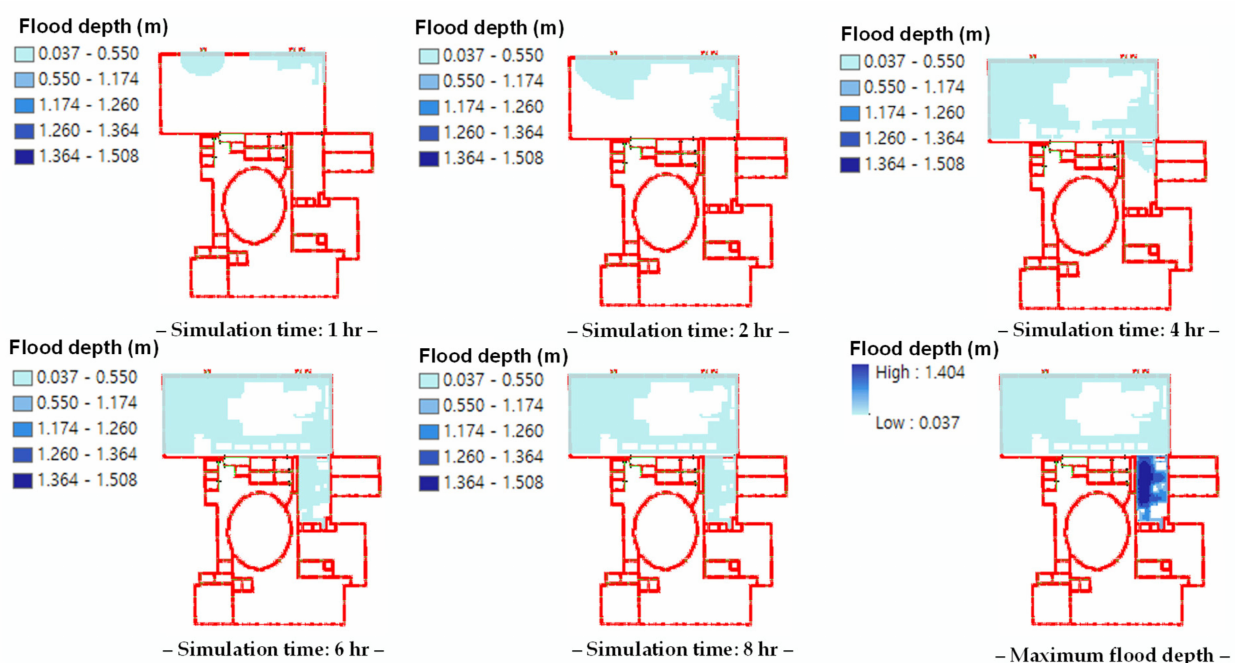
Figure 10. 2D internal flood analysis for a return period of 10 7 years (NPP